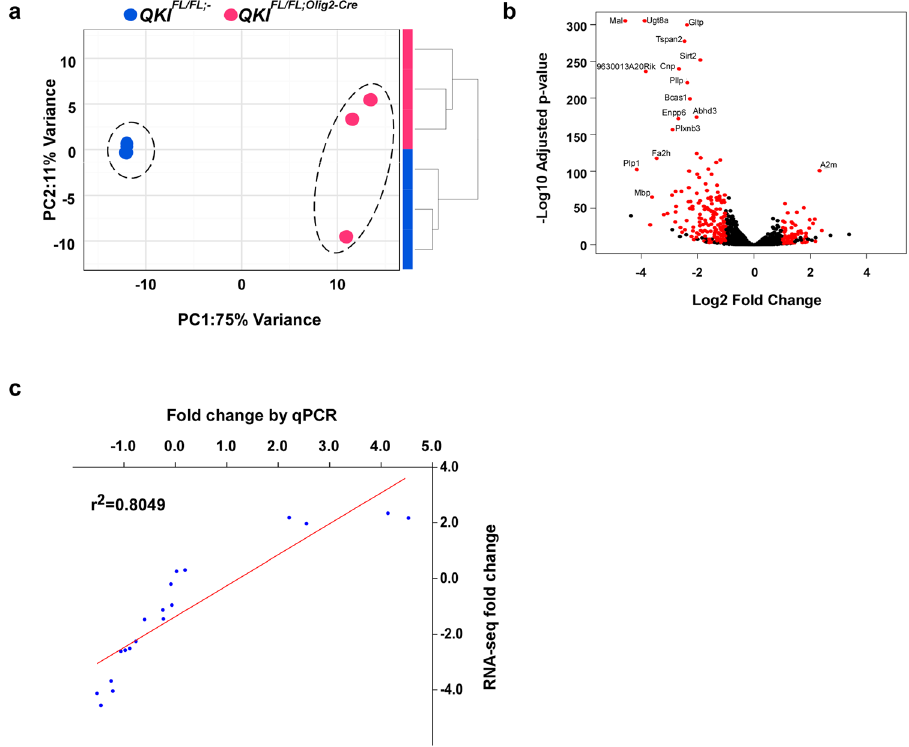
Figure 1. Gene expression profiles comparing brains of QKI FL / FL ; Olig2 - Cre and QKI FL / FL ;- mice. ( a ) Global effects of QKI FL/FL;Olig2-Cre on cells were evaluated by unsupervised clustering of samples based on expression profiles of 1,000 most variant genes. QKI FL/FL;Olig2-Cre and QKI FL/FL;- mice form robust, distinct clusters, both with hierarchical clustering (right) and Principal Component Analysis (left). ( b ) Volcano plot representing the results of differential expression analysis. Genes with adjusted p-value < 0.05, absolute fold change > 2 and base mean > 100 are colored in red. ( c ) Validation of RNA-seq data by qPCR with 19 transcripts. RNA-seq data strongly correlated with qPCR data (r 2 = 0.8049, p < 0.0001, Pearson correlation coefficient).